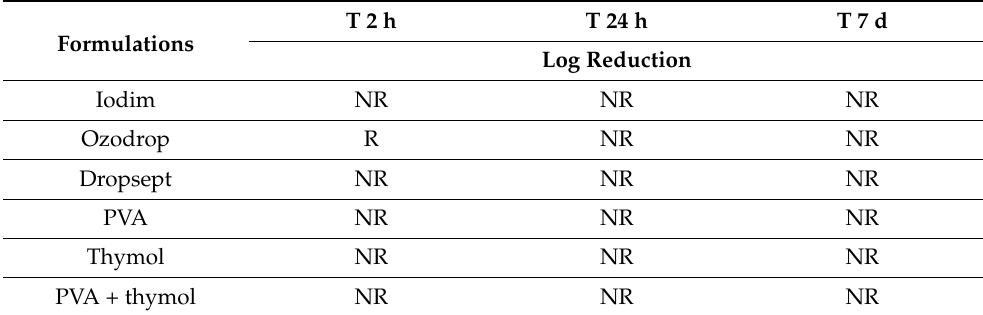
Table 8. Challenge test on E. coli